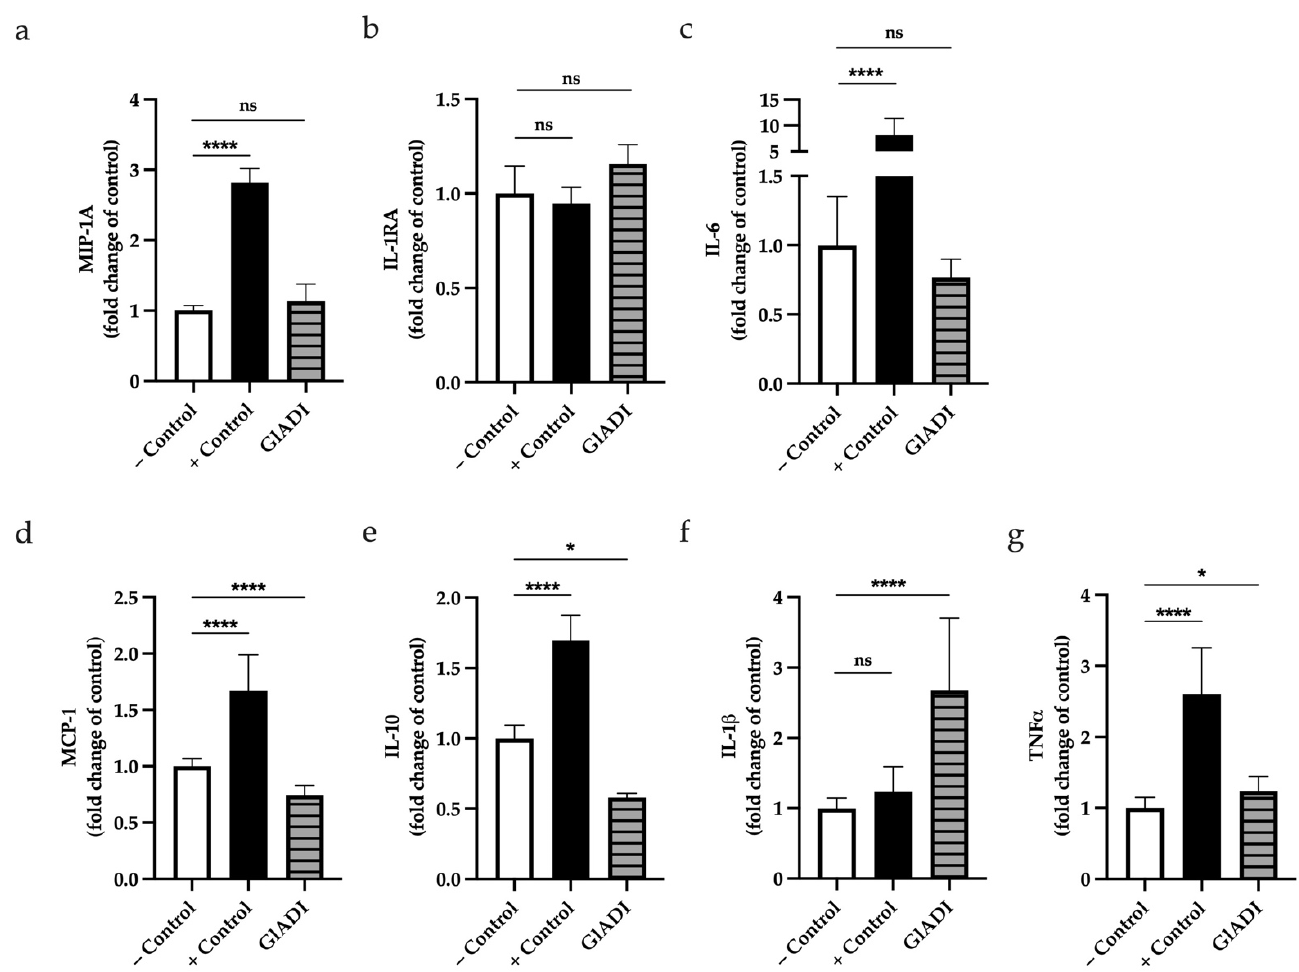
Figure 9. Cytokine production by DCs pre-treated with GlADI 500 ng/mL. GlADI had no effect on the production of ( a ) MIP-1A), ( b ) IL-1RA, and ( c ) (IL-6), whereas it caused a significant decrease in the production of ( d ) MCP-1 and ( e ) IL-10. Significant increases in the production of ( f ) IL-1 β and ( g ) TNF α are shown. Results are shown as fold change of the untreated control. Positive and negative control experiments are shown as − Control and + Control, respectively. A p -value < 0.05 was statistically significant (* p < 0.05, **** p < 0.0001, ns = no significant).